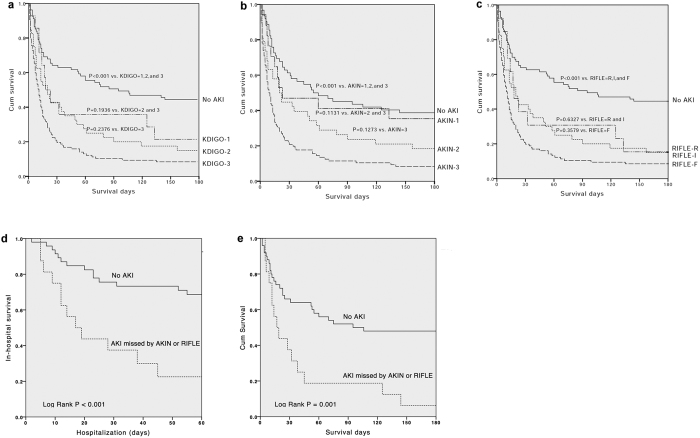
Survival Functions.Kaplan-Meier survival analysis for 242 critically ill cirrhotic patients according to the 3 AKI classifications on the first day of ICU admission. (a) Based on the KDIGO classification, the 180-day cumulative survival rates differed significantly for patients without AKI versus patients with KDIGO stages 1 to 3 (p < 0.001). The comparisons between patients with KDIGO stage 1 and those with KDIGO stages 2 to 3, and between patients with KDIGO stages 2 and those with KDIGO stage 3 have been depicted on the figure. (b) Based on the AKIN classification, the 180-day cumulative survival rates differed significantly for patients without AKI versus patients with AKIN stages 1 to 3, p < 0.001). The comparisons between patients with AKIN stage 1 and those with AKIN stages 2 to 3, and between patients with AKIN stages 2 and those with AKIN stage 3 have been depicted on the figure. (c) Based on the RIFLE classification, the 180-day cumulative survival rates differed significantly for patient without AKI versus patients with RIFLE-R, RIFLE-I, and RIFLE-F (p < 0.001). The comparisons between patients with RIFLE-R and those with RIFLE-I to F, and between patients with RIFLE-I and those with RIFLE-F have been depicted on the figure. (d) Patients with AKI diagnosed according to KDIGO but missed by AKIN or RIFLE classification had significantly lower hospital survival rate than patients without AKI (Log Rank P < 0.001). (e) Patients with AKI diagnosed according to KDIGO but missed by AKIN or RIFLE classification had significantly lower 180-day cumulative survival rate than patients without AKI (Log Rank P = 0.001). * Abbreviation: AKI, acute kidney injury; RIFLE, risk of renal failure, injury to kidney, failure of kidney function, loss of kidney function, and end-stage renal failure; AKIN, acute kidney injury network; KDIGO, kidney disease improving global outcomes.